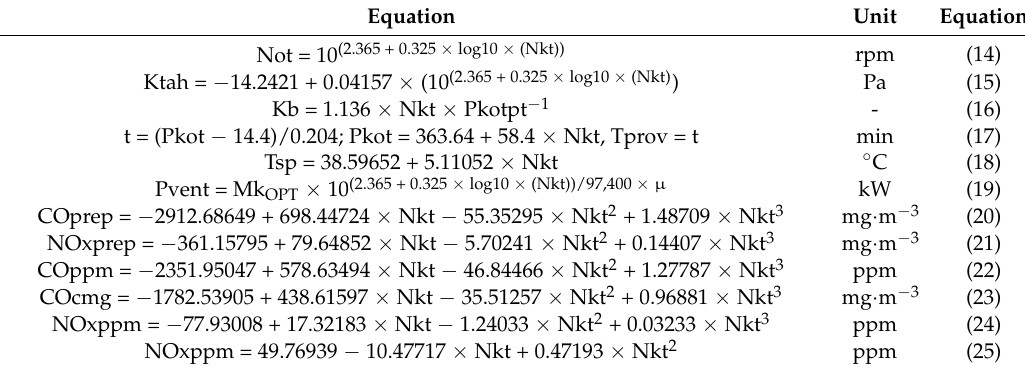
Table 2. Working times of parameters for boilers of 23 (kW) depending on Nkt (Figure 7). Equation Unit